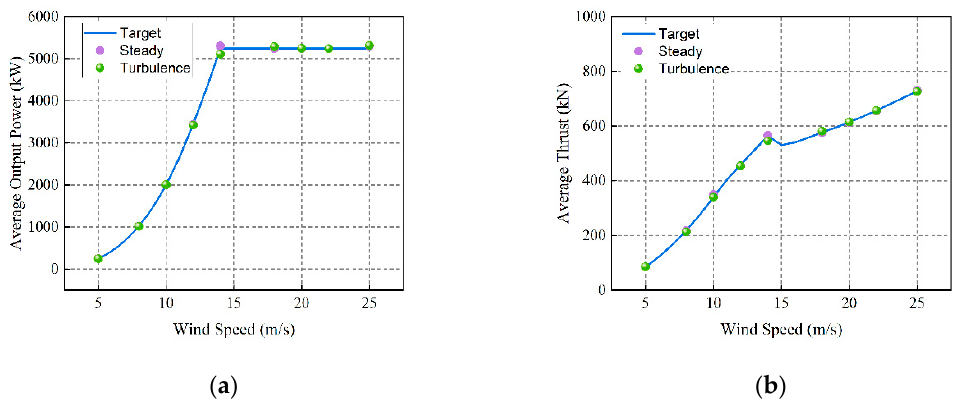
Figure 12. Aerodynamic performance of the VAWT under different wind speeds. ( a ) Output power; ( b ) Thrust.